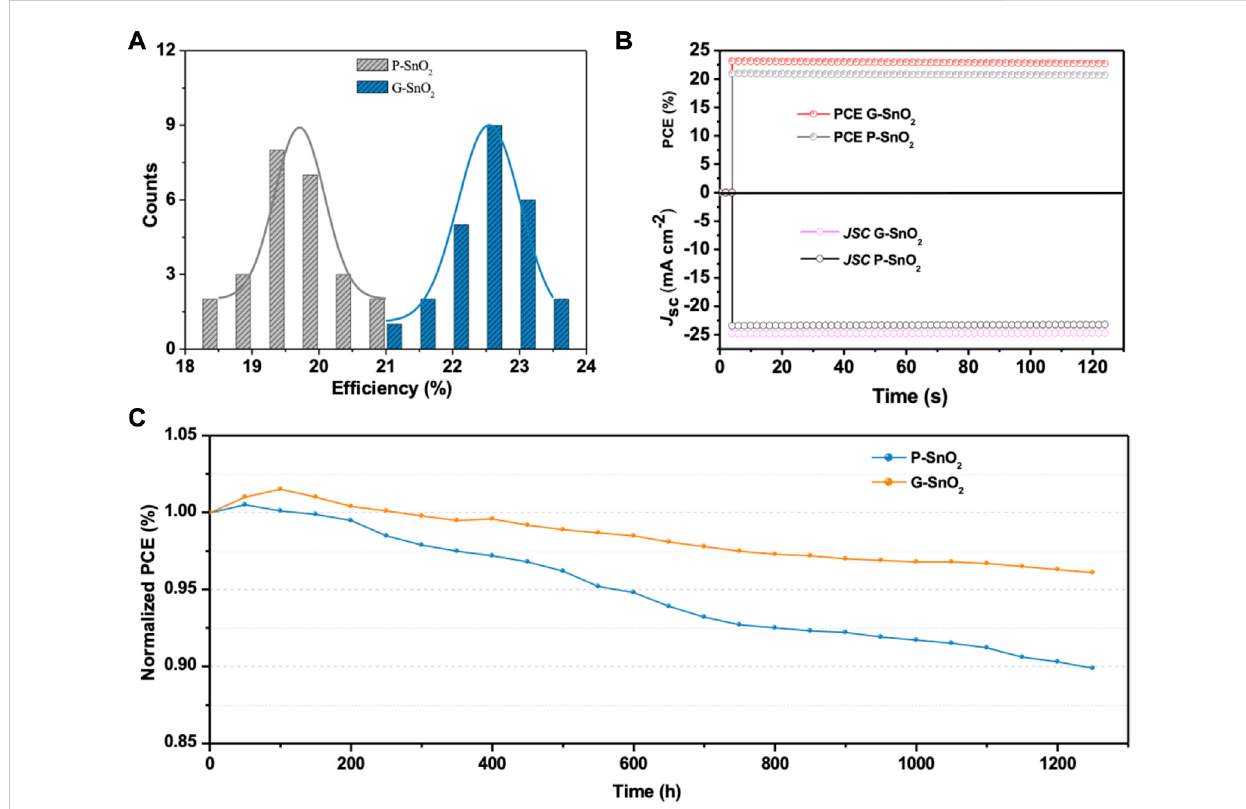
FIGURE 5 (A) Statistical distribution of the PCE of PSCs prepared with P-SnO 2 and G-SnO 2 (25 devices in each group). (B) Steady-state photocurrent density and device ef fi ciency atmaximum power point undercontinuousAM 1.5G illumination. (C) PCE decrease underdry air atmosphereof areference